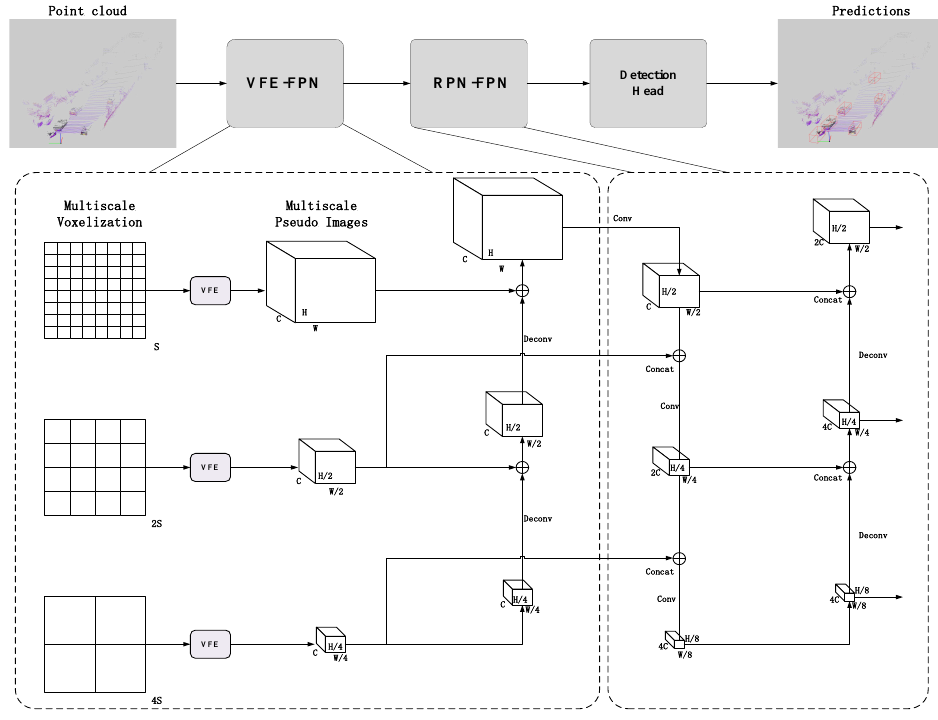
Figure 1. The structure of the network. The detector takes the raw point cloud as input, converts it into multiple-scale voxels, and uses voxel feature encoding VFE-FPN to extract and fuse voxel features of different sizes. Then, an RPN-FPN network is used to integrate multi-scale features. Finally, detection head (Single Shot Detector (SSD)) is used for